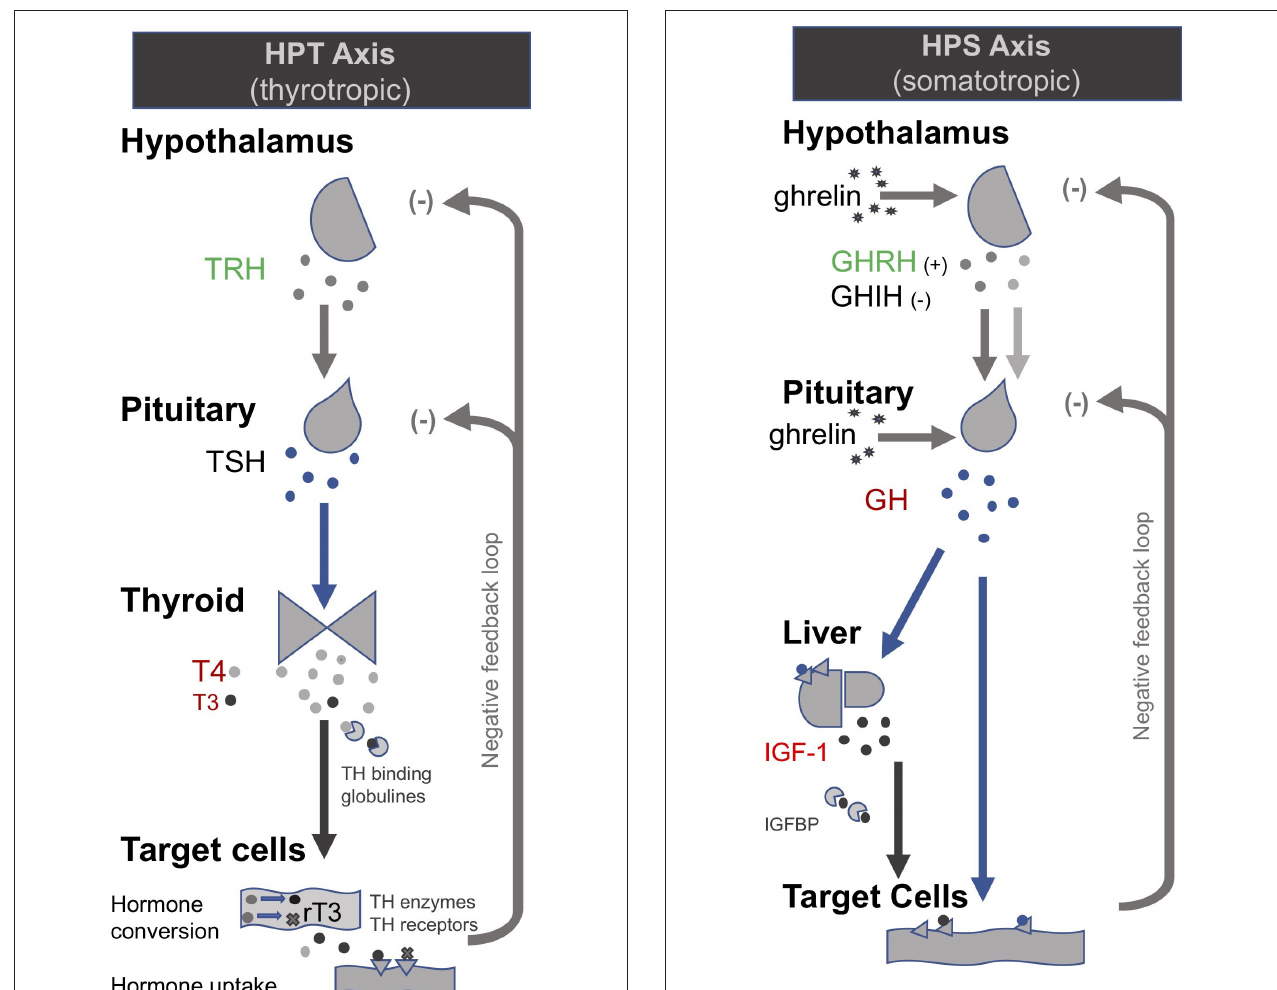
FIGURE 2 | The somatotropic axis (HPS axis) [modified from (34)].